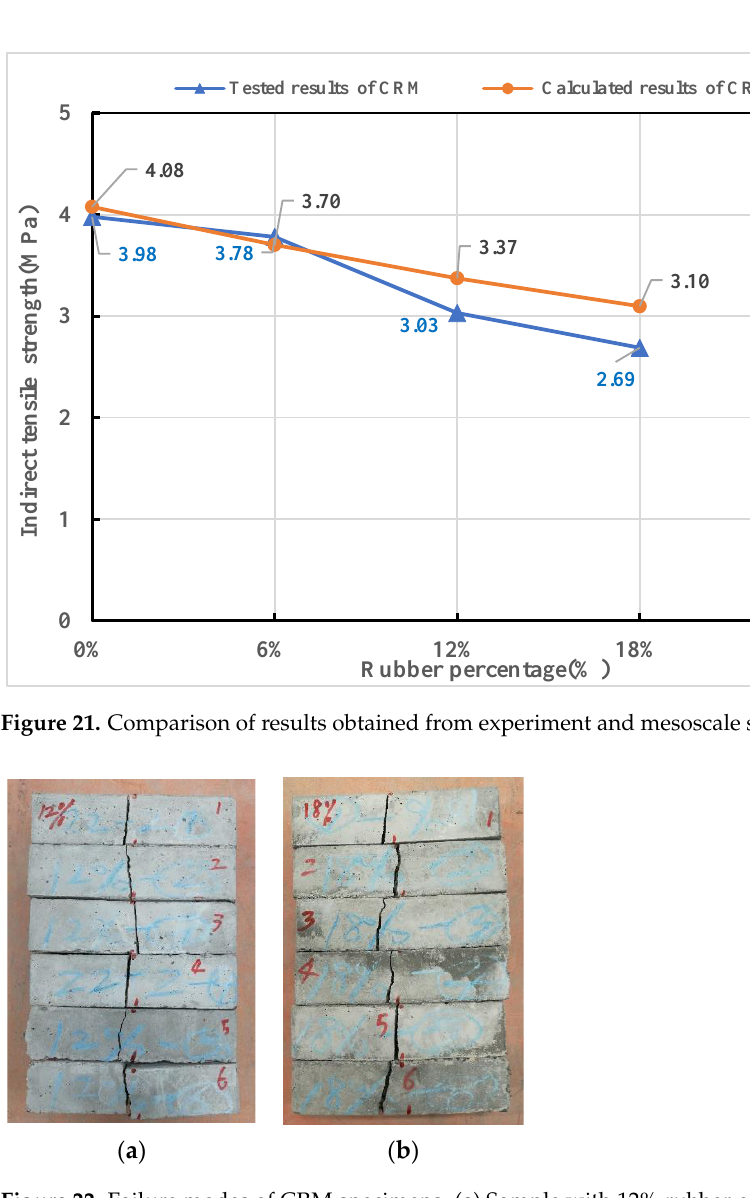
Figure 22. Failure modes of CRM specimens. ( a ) Sample with 12% rubber content. ( b ) Sample with 18% rubber content. Table 10. Test results of flexural strength.